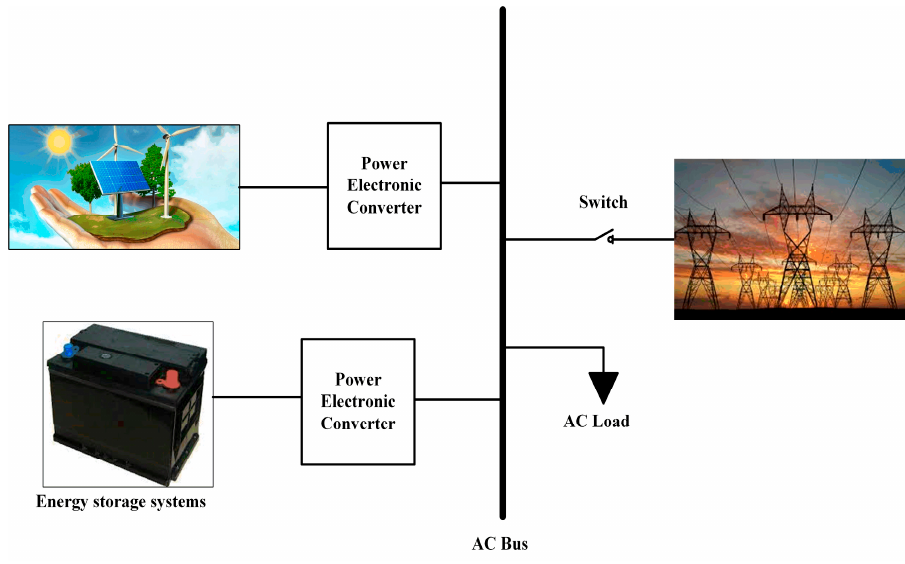
Figure 22. Energy Storage System (ESS) support for RES issues.